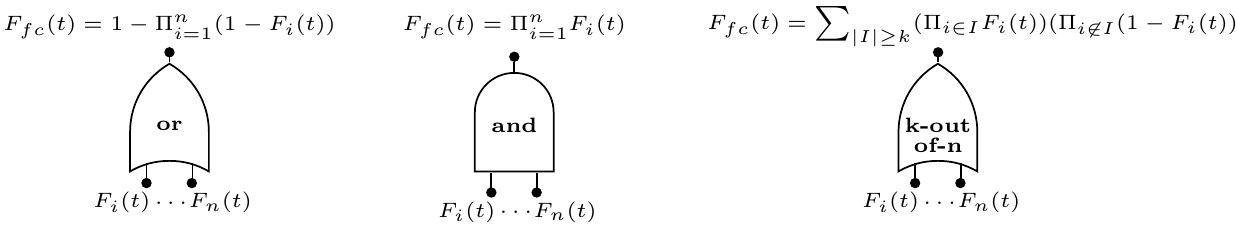
Figure 3. Cumulative distribution function ( F